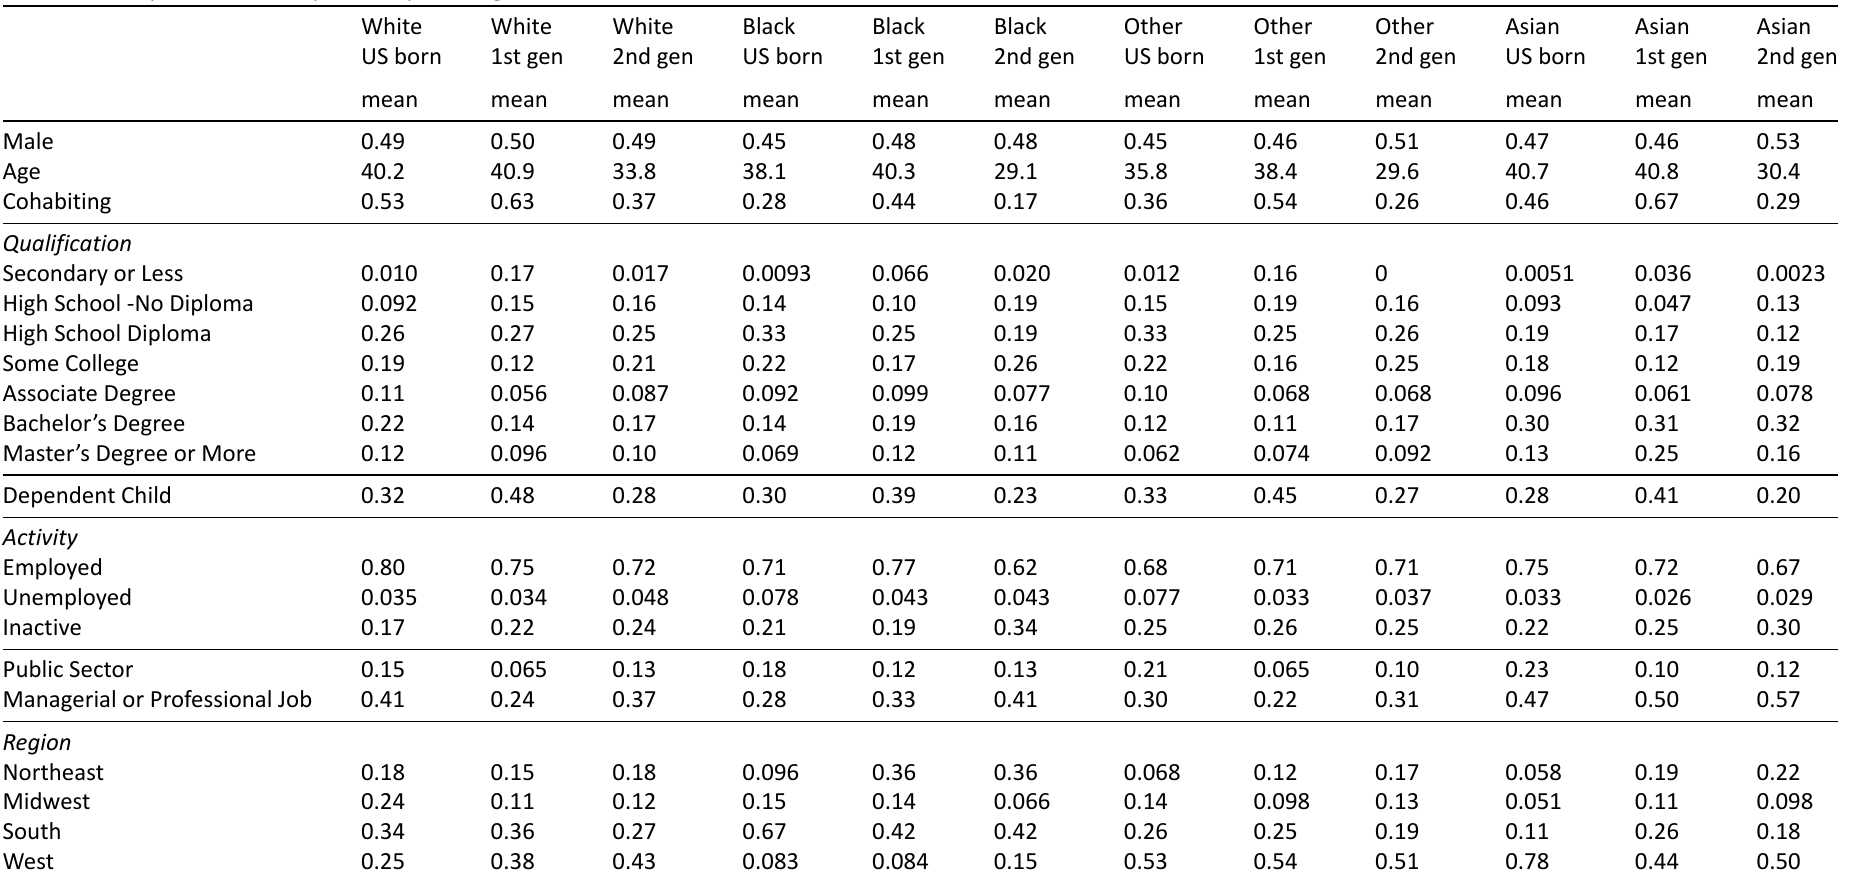
Table 1. Descriptive statistics by ethnicity and migrant